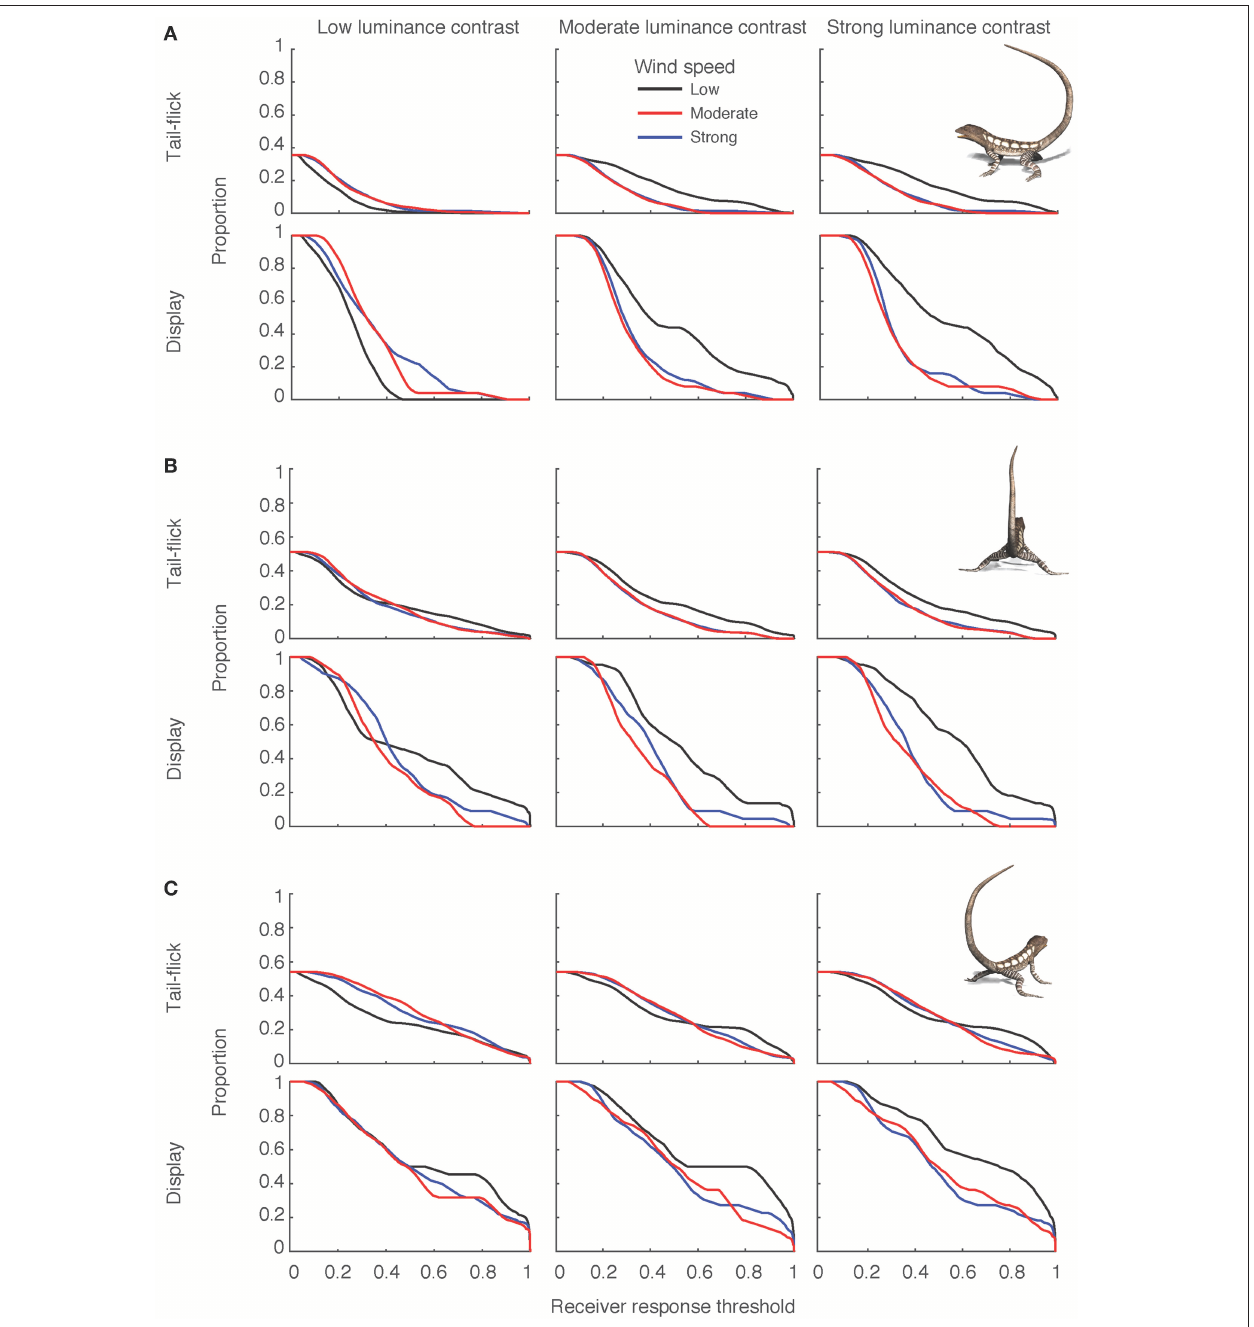
FIGURE 7 | Signal effectiveness was influenced by signaler orientation, but was also mediated by the type of movement. Each plot shows the proportion of the lizard display with salience scores exceeding receiver thresholds for response, presented separately for the tail flick and rest of the display for three orientations: (A) side-on, (B) viewed from behind, (C) angled toward the right. Separate plots are shown for scenes with low (left column), moderate (middle column), and strong (right column) luminance contrast, while in each plot, lines represent low (black), moderate (blue), and strong (red) wind conditions.